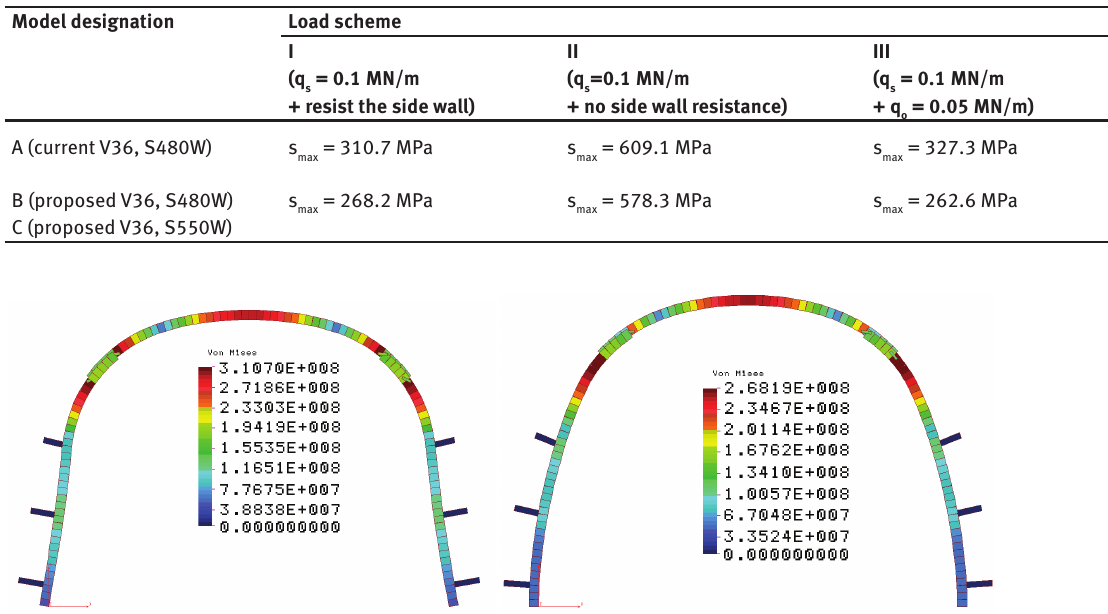
Figure 8: The map of reduced stresses in the A (left) and B and C (right) frames for load scheme I ( q scale 10×).